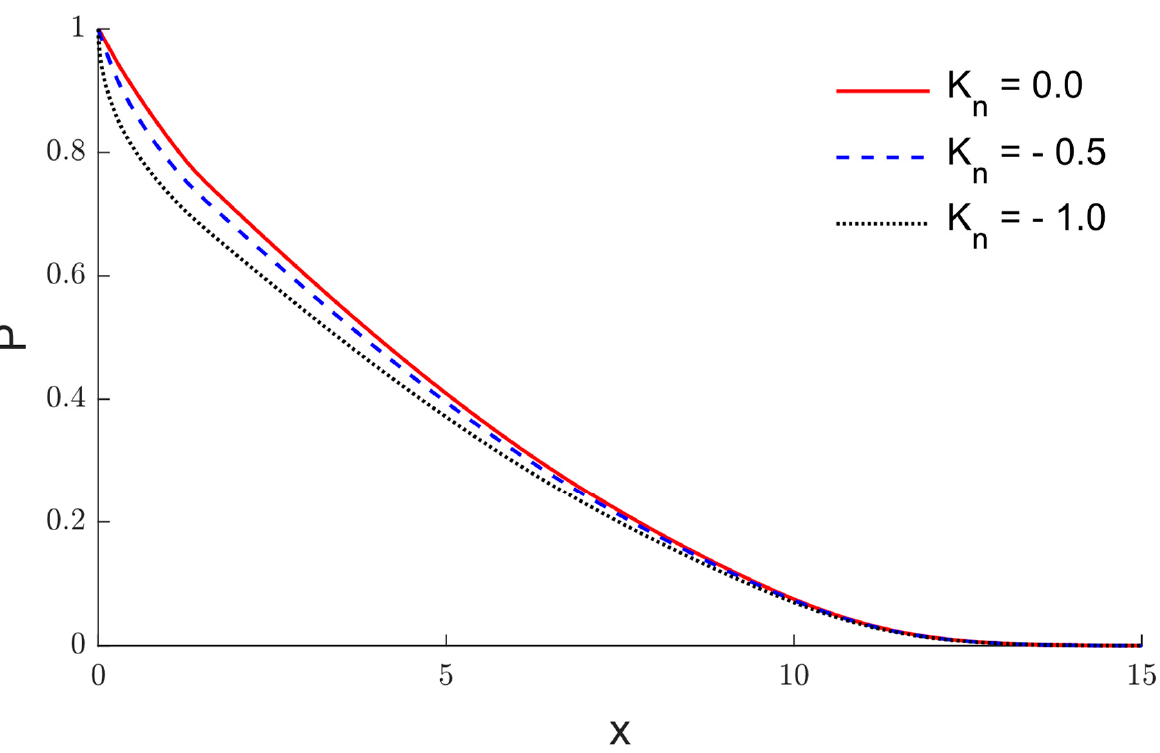
Figure 5. The impact of variable thermal conductivity and diffusivity in the chemical potential variation P via the distance x when τ o = τ 1 = 0.05 .